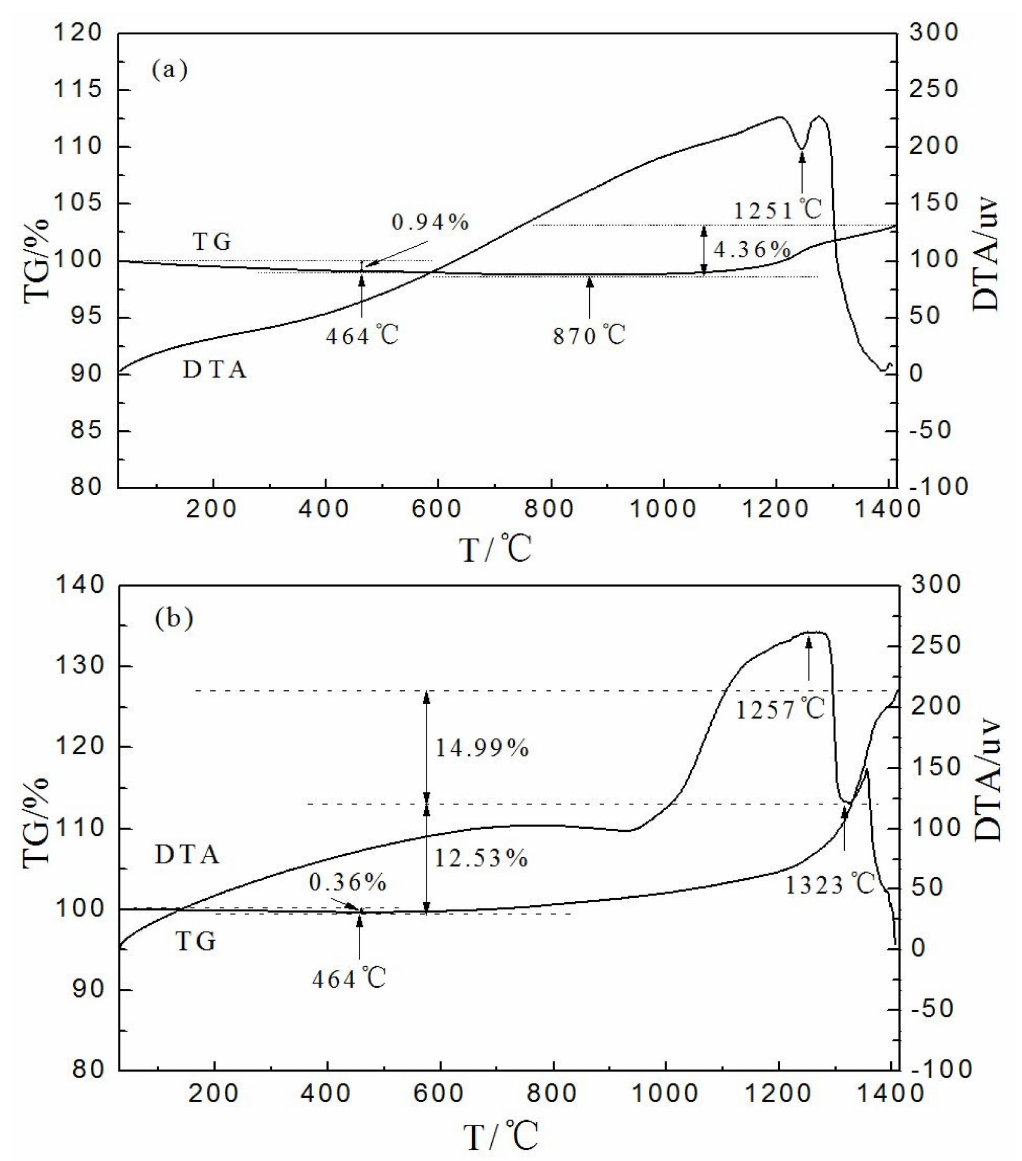
Figure 3. Thermoanalysis (TG-DTA) curves of: ( a ) raw cBN grains; and ( b ) Ni plated